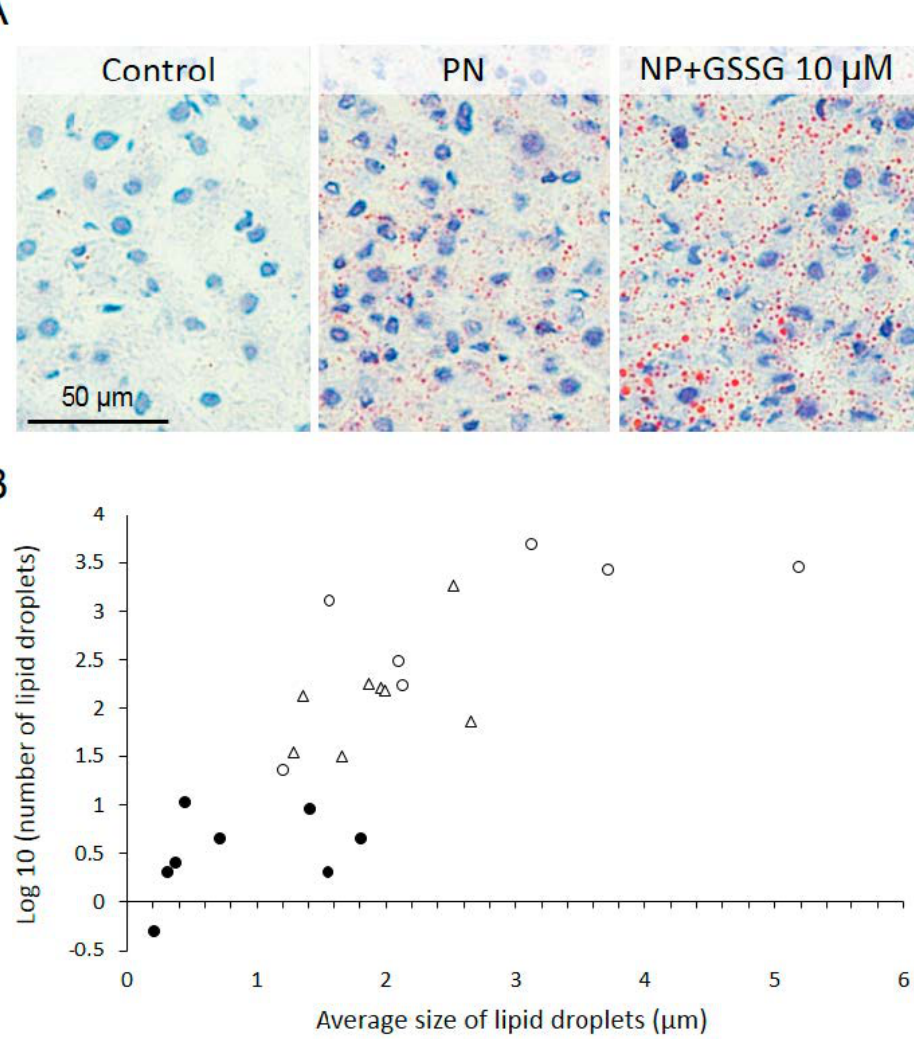
Figure 2. Evaluation of hepatic lipid content. ( A ) Representative picture of each studied group. ( B ) Lipid droplets in function of their number (log 10 ), size ( µ m), and groups (Dark circle: Reference group. Open triangle: Parenteral nutrition (PN) group. Open circle: PN + 10 µ M GSSG group). PN ± GSSG induced an increased ( p < 0.01) number of hepatic lipid droplets.